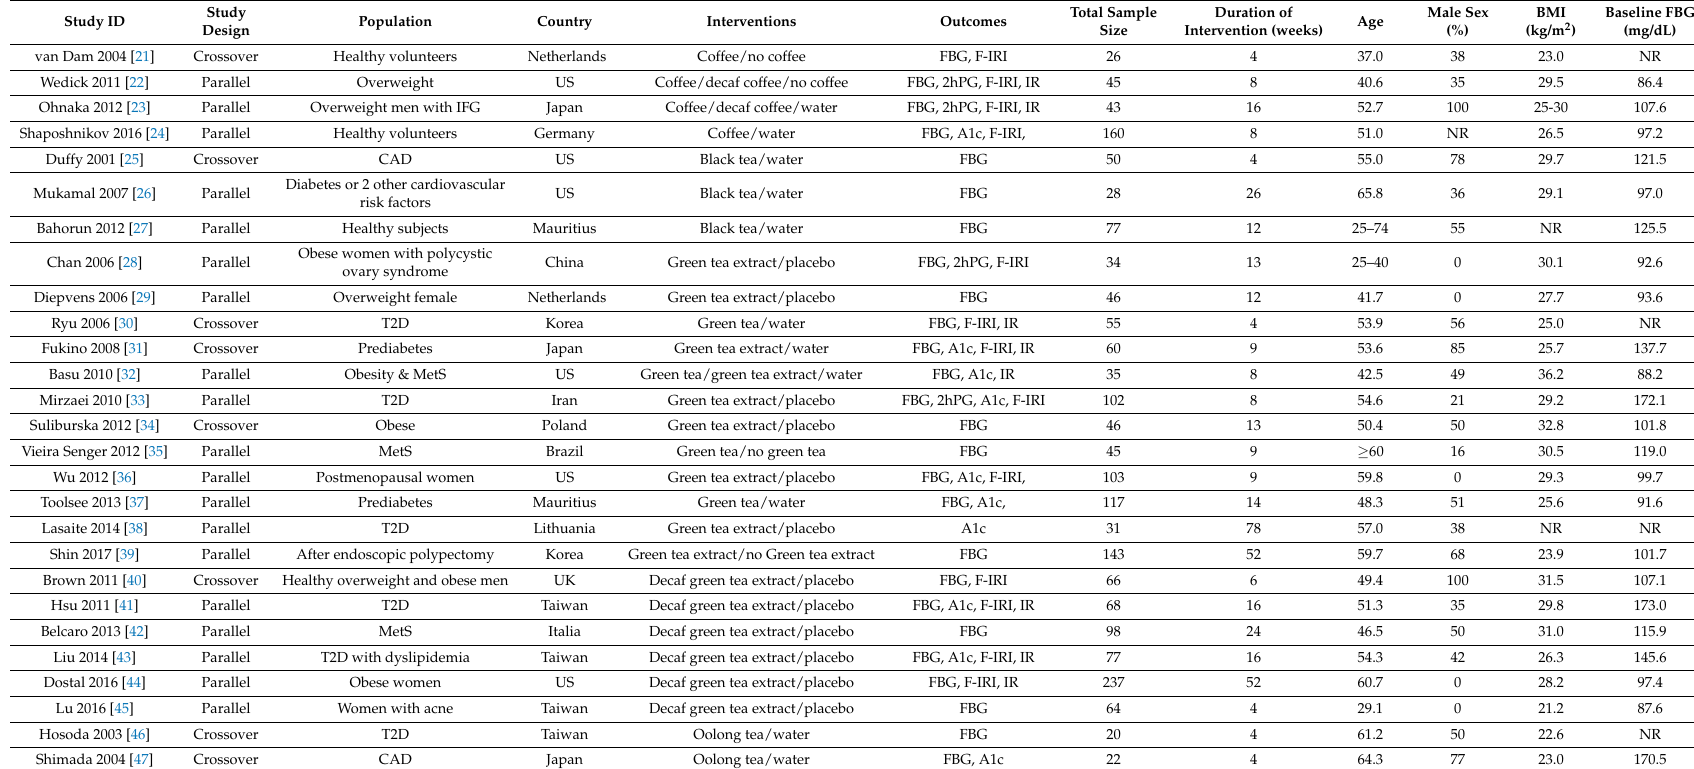
Table 1. Characteristics of the included